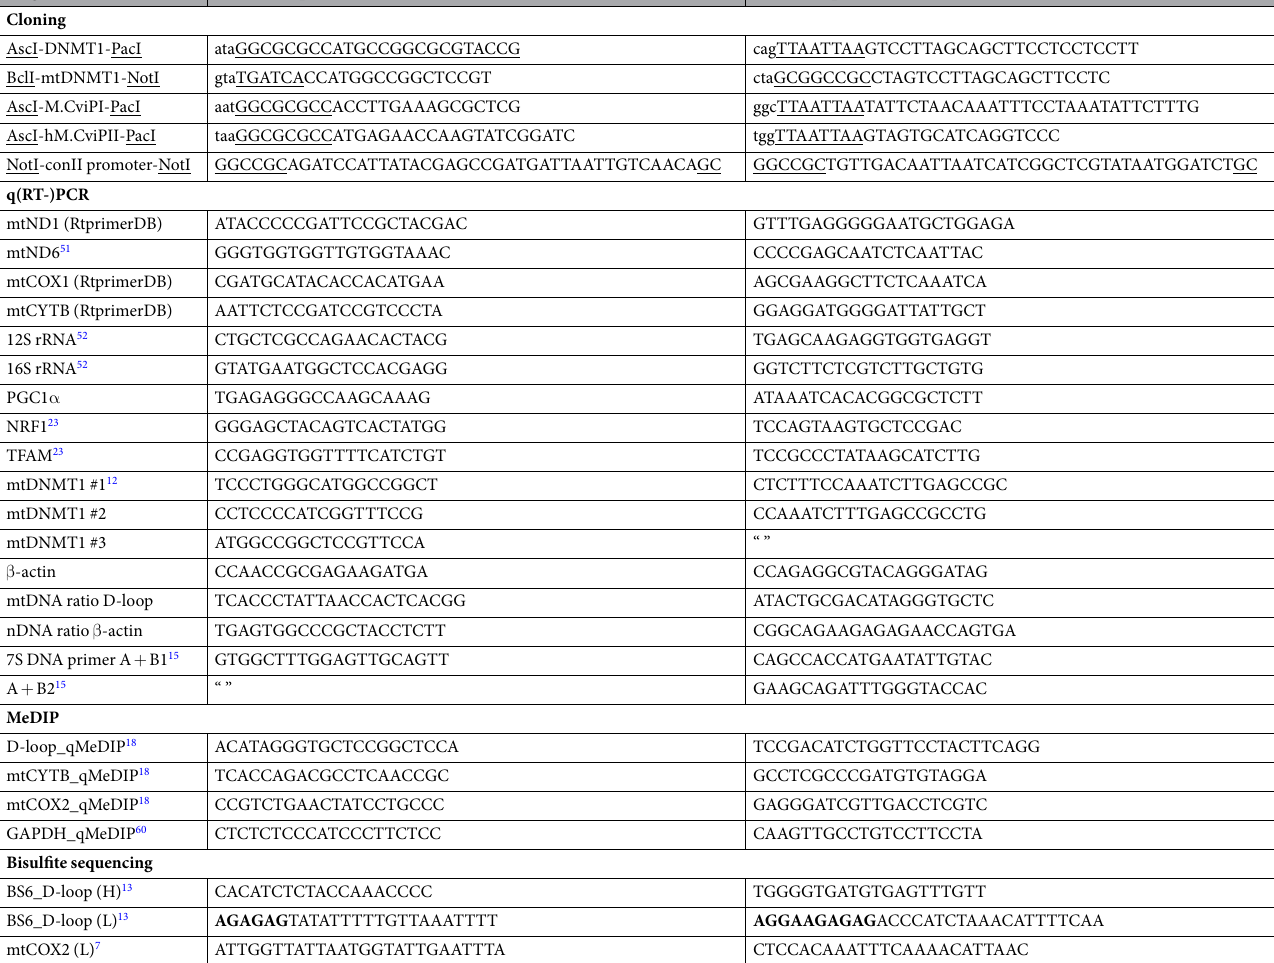
Table 1. Primer sequences. Restriction sites are underlined. The 6- to 10-bp tags added to primers are indicated in